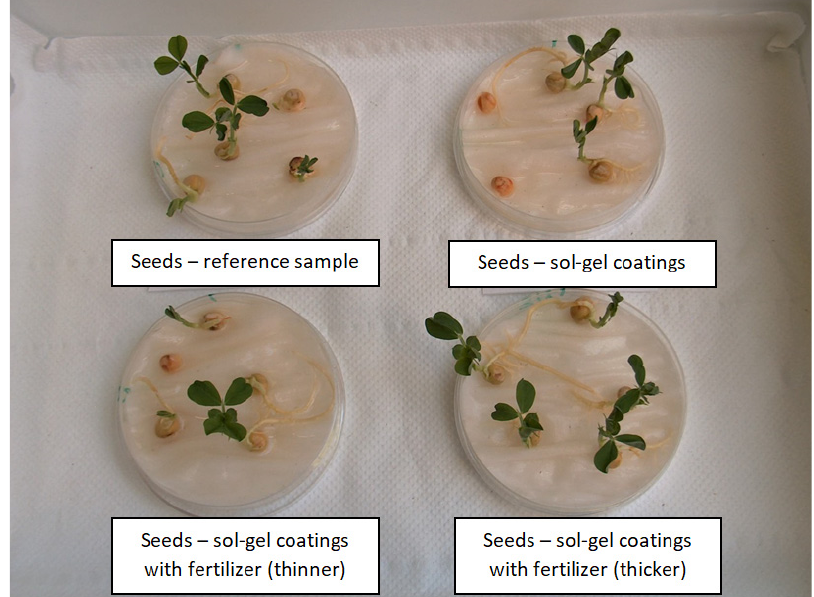
Figure 5. Photos of the researched seeds one week after sowing.